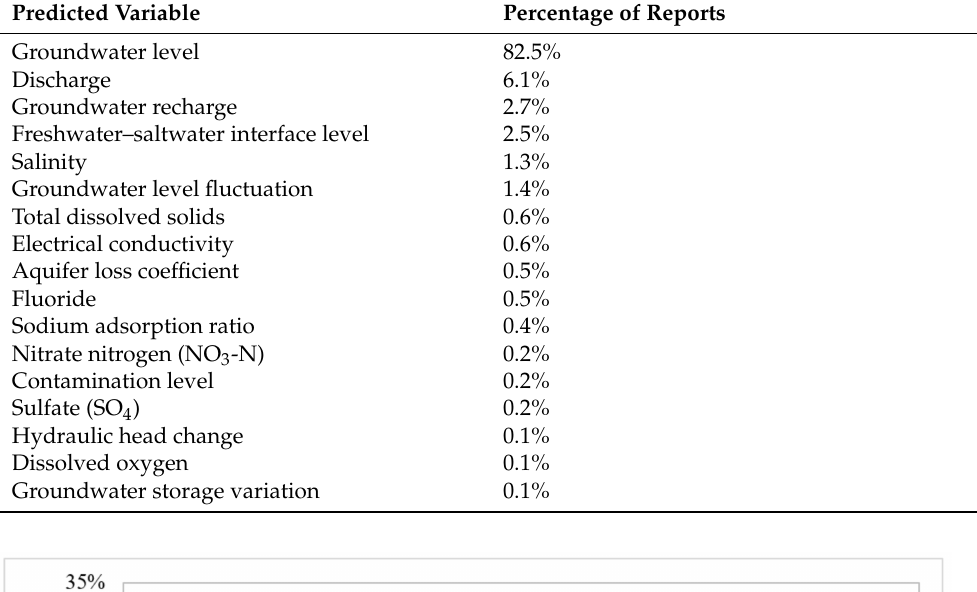
Table 1. Groundwater characteristics predicted by ML models in the reviewed articles.